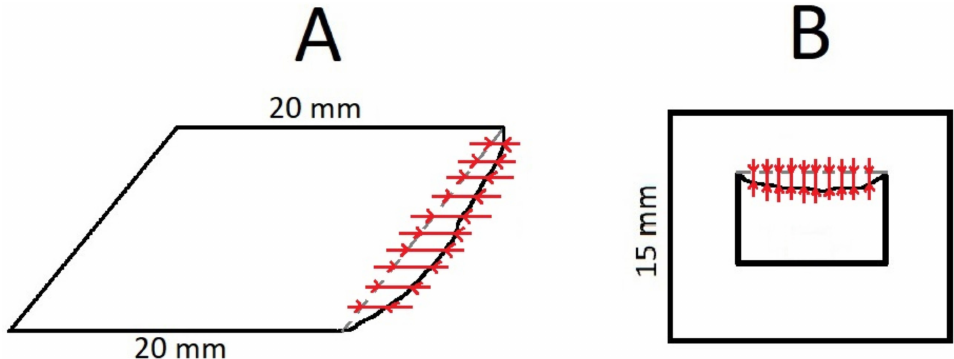
Figure 4. Measured dimensions on the overhang ( A ) and bridge ( B )